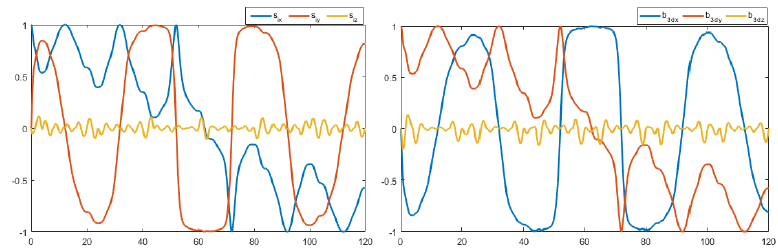
Figure 16. The pointing and thrust directions of the flight in terrain 1.